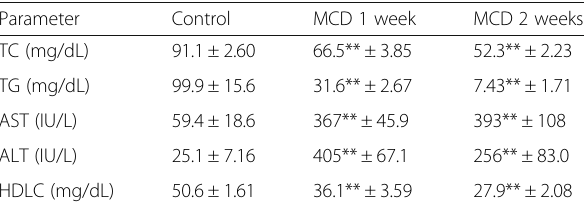
Table 1 Plasma parameters in mice fed control or methionine- and choline-deficient (MCD) diet for 1 and 2 weeks Parameter